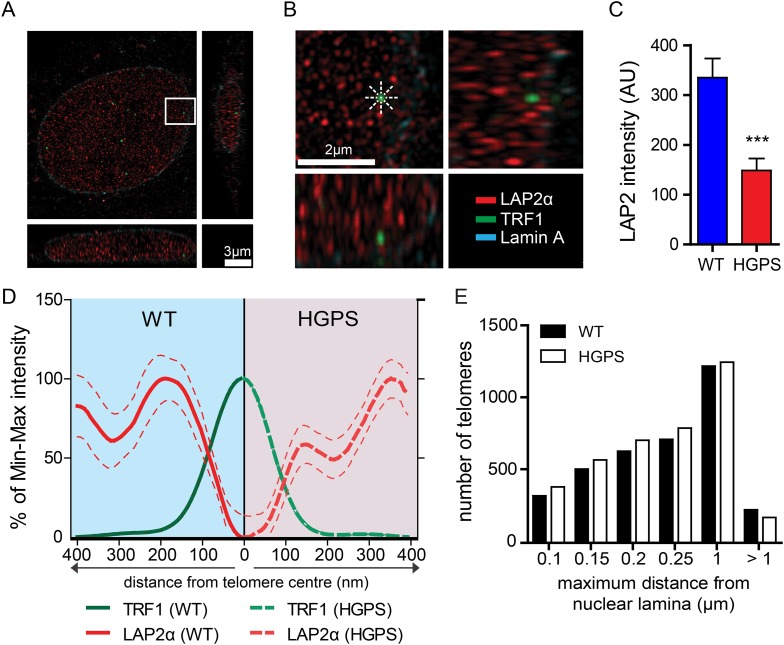
LAP2α association with telomeres.(A, B) Projection of an extended section of a wild-type fibroblast nucleus showing lamin A (blue), LAP2α (red) and TRF1 (green) staining. Magnified section indicated by the white frame is shown in panel (B). The eight radiuses used to measure the distribution profile of LAP2α around each telomere are indicated by the dotted white lines. (C) Average LAP2α intensity in WT or TERT+HGPS nucleus (n = 17, ***p < 0.001, errors bars indicate SEM, Student's t-test). (D) Intensity profile of LAP2α (red) near telomeres (TRF1, green) in WT (left part, blue) or TERT+HGPS (right part, red) nuclei along ∼400 nm axis, relative to the minimum and maximum LAP2α and TRF1 signal per nucleus. Dotted lines indicate SEM, n ≥ 88. (E) Quantification of telomere distance to the nuclear lamina (a total number of 2891 telomeres from 34 nuclei were analyzed).